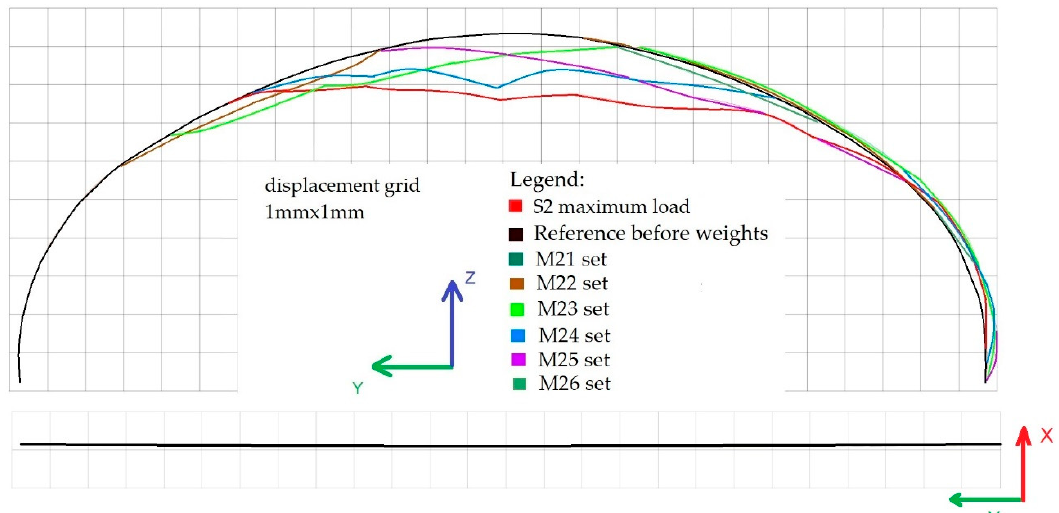
Figure 13. Deformations of the bridge cross section 2-2 in the Y-Z (top) and X-Y (bottom) planes under loading schemes S1 and M11–M16.